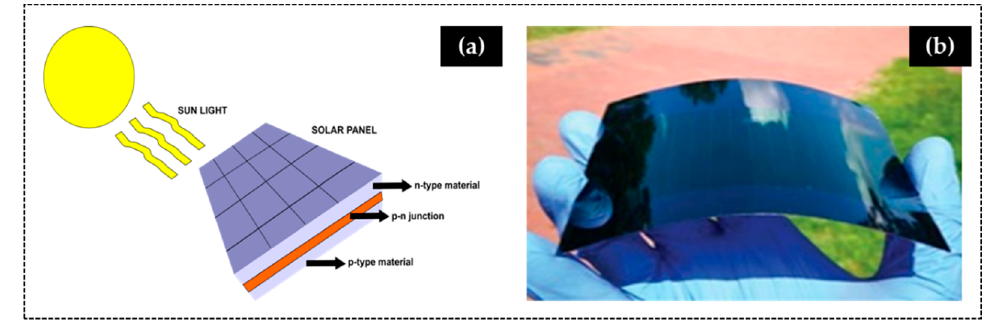
Figure 6. ( a ) Schematic of operation of a solar panel and ( b ) a solar cell produced with Corning ® Willow ® Glass (reprinted from [115] © 2021 with permission from Willey).